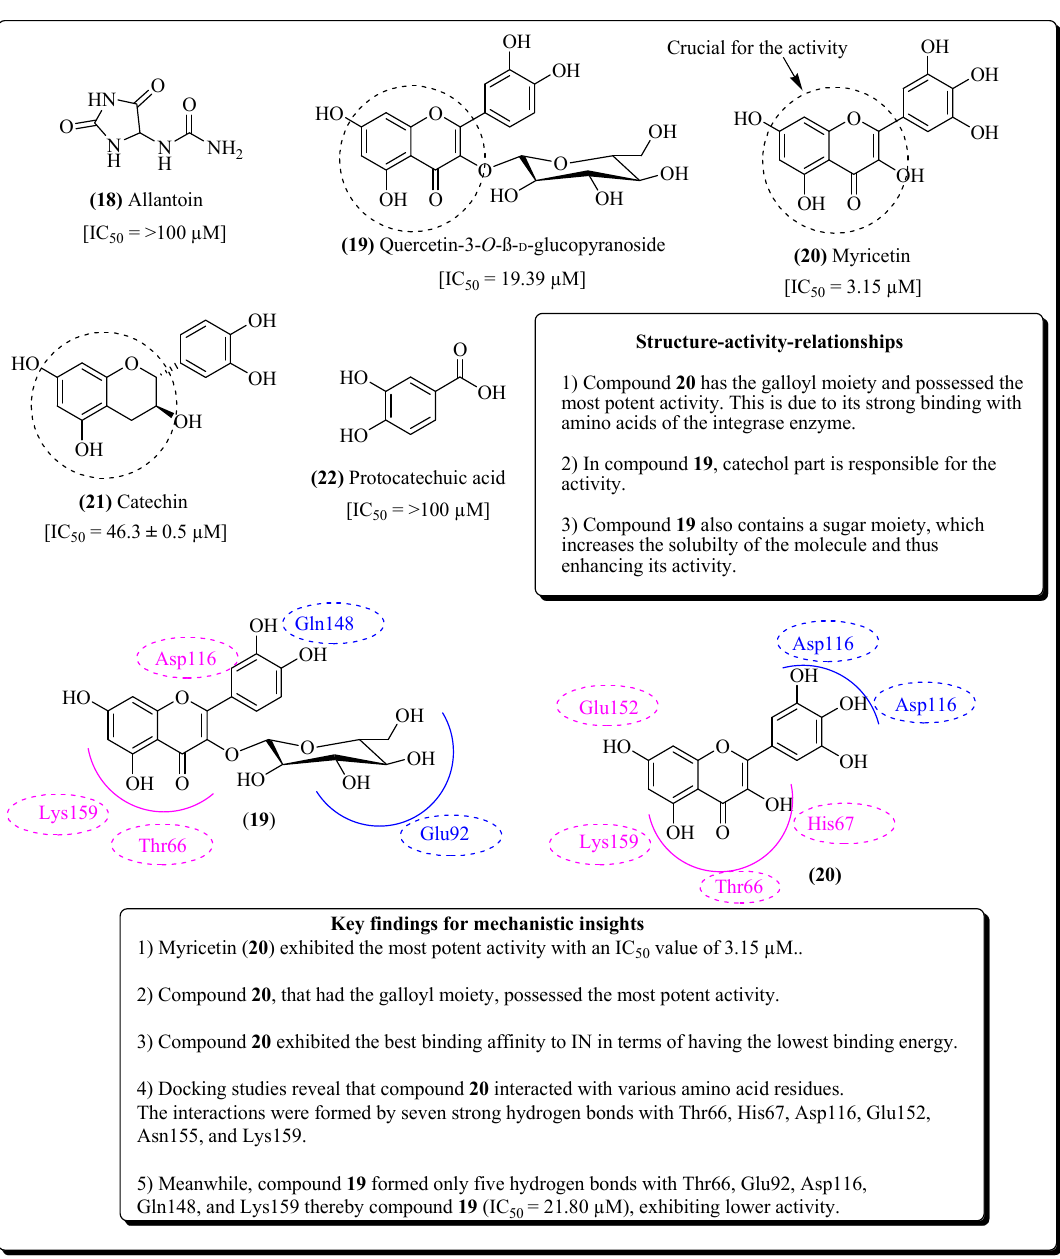
Figure 6. Structure-activity-relationships of naturally occurring integrase inhibitors.